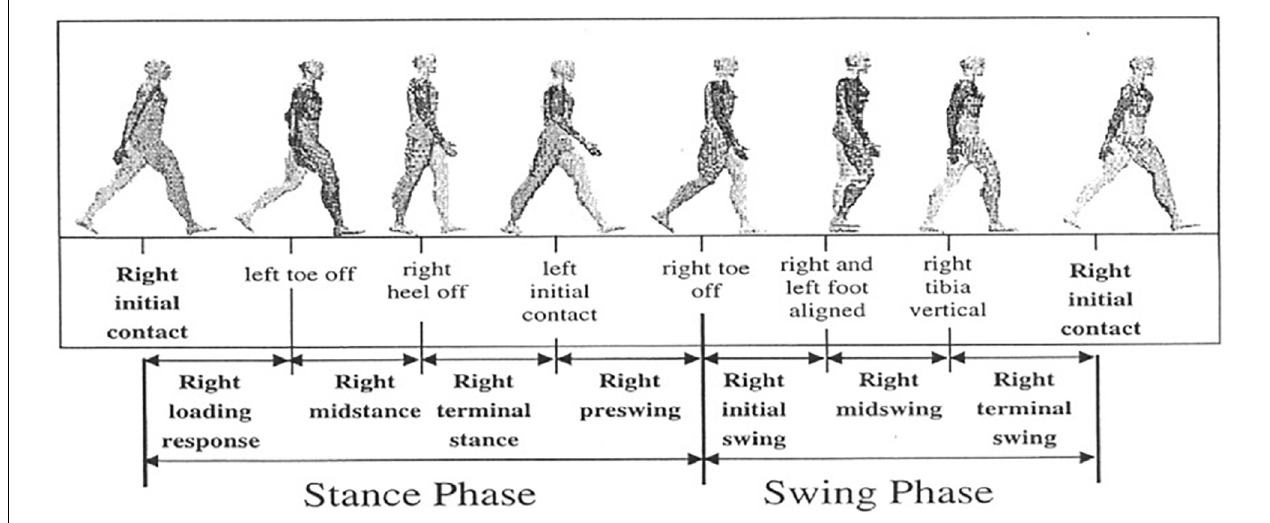
FIGURE 1 | Gait phases and used terminologies to partition the phases. For the representational purpose, the gait segmentation of the right leg (ipsilateral) is described w.r.t. the left (contralateral) leg. [Image source: Li et al. (2016a), the open-access article under the CC BY-NC-ND